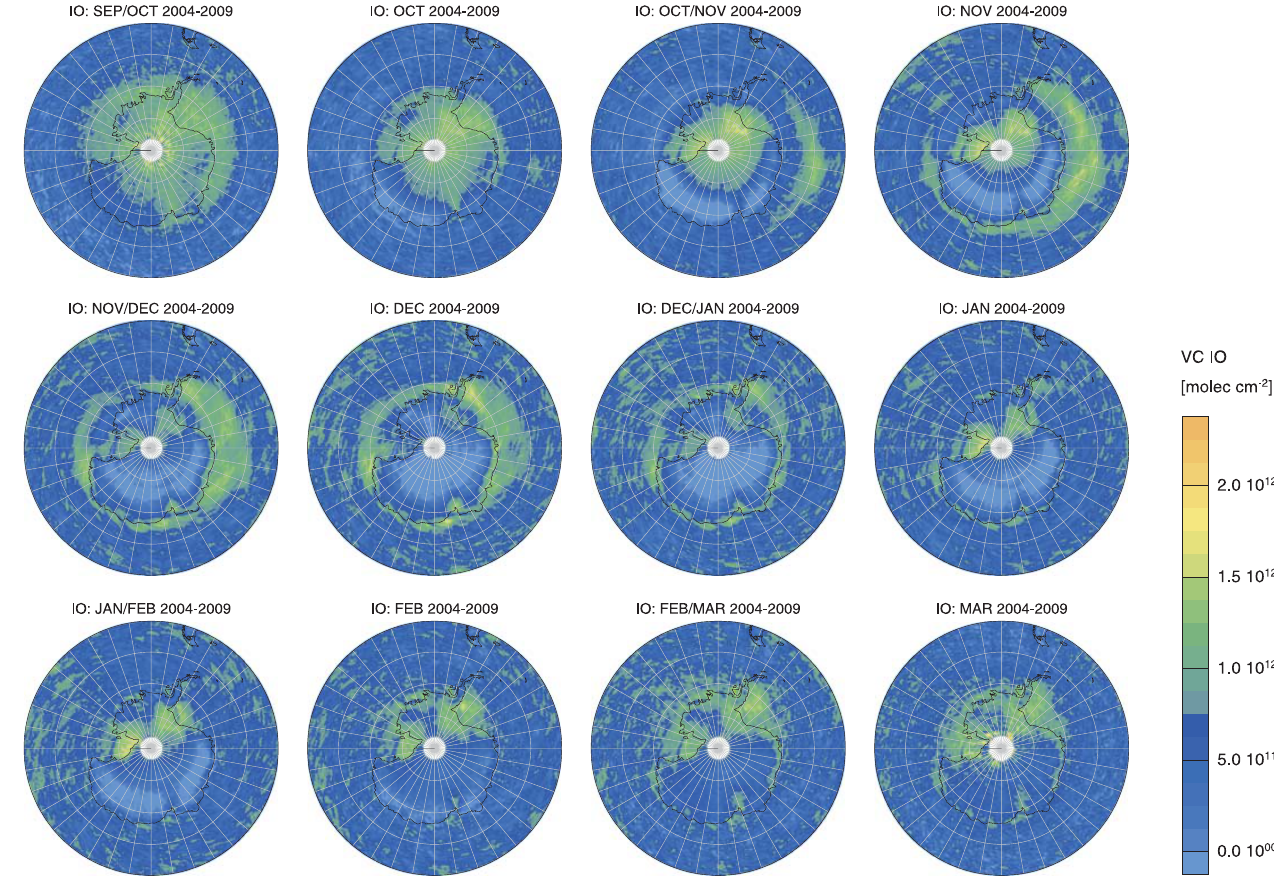
Fig. 4. Monthly maps of IO vertical column amounts on the Southern Hemisphere (up to 50 ◦ S) averaged over six subsequent years each (2004–2009), the individual averaging periods are given in the